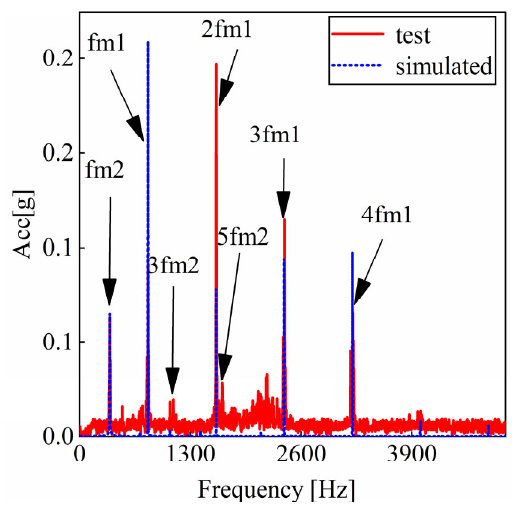
Figure 11. Frequency domain diagram of vibration acceleration of the helical gear in normal state.